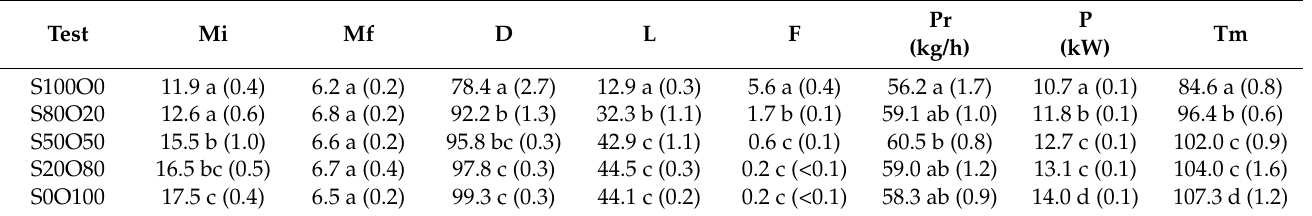
Table 6. Results of pelletisation tests with different blends of olive pruning residues and spruce sawdust (average values with standard deviation in parenthesis).